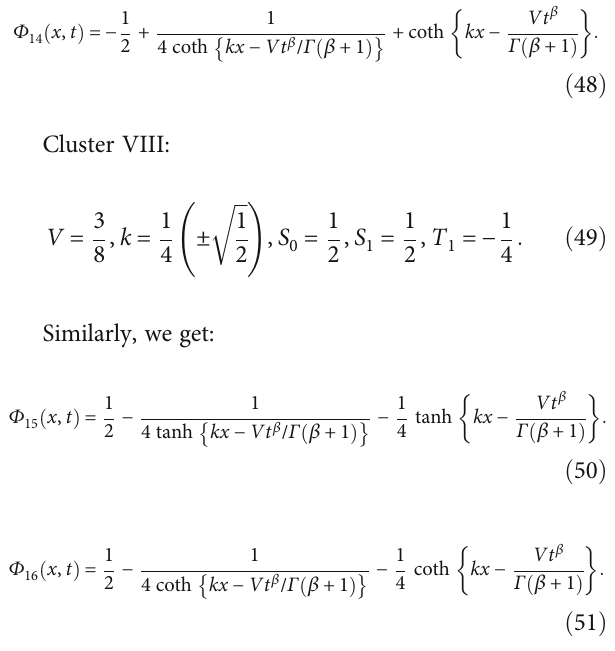
Figure 8: The graphical representation of the solution Φ real contour plot, and (d) imaginary contour